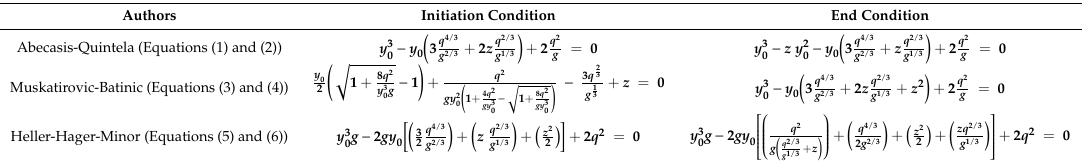
Table 12. Relationship between z / y 0 and the Froude number F 0 at the lowest point of the flip bucket, expressed as a function of the flow depth y 0 and the unit flow rate q